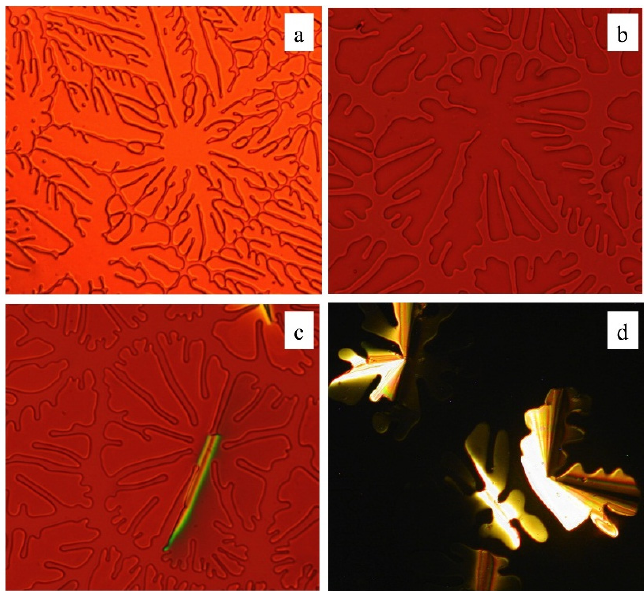
Figure 4. Representative polarized optical micrographs of columnar phases formed upon cooling from the isotropic phase of ( a ) 2b ; ( b ) 4 ; ( c ) 6c and ( d ) 7 (200× magnification). Images ( a )–( c ) viewed employing a 530 nm quarter wavelength retardation plate in order to improve viewing contrast.